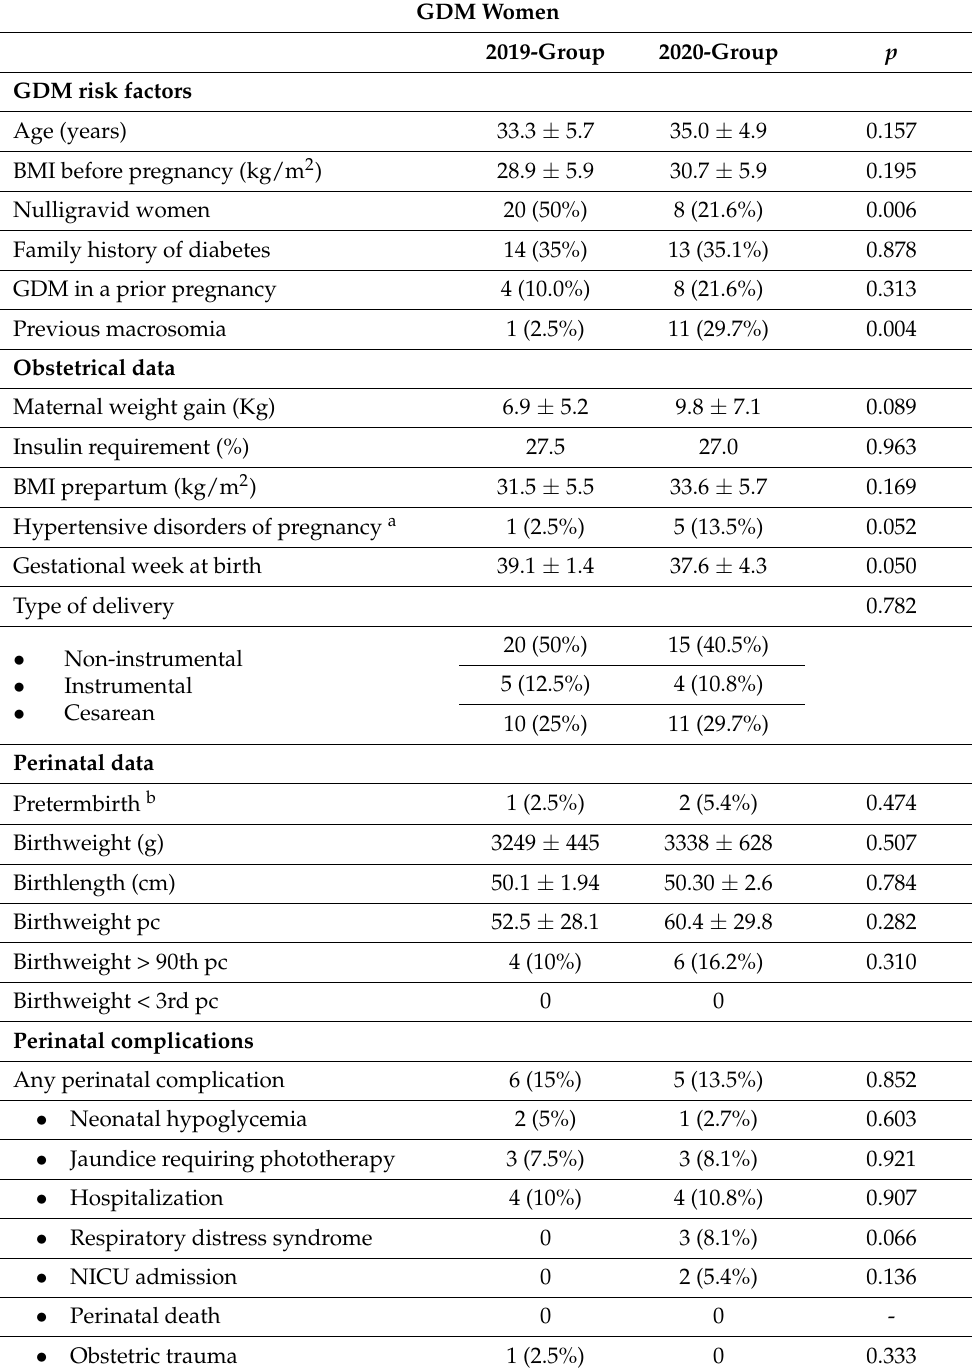
Table 2. Comparison between GDM women in 2019-group vs. 2020-group: GDM risk factors, obstetrical and perinatal